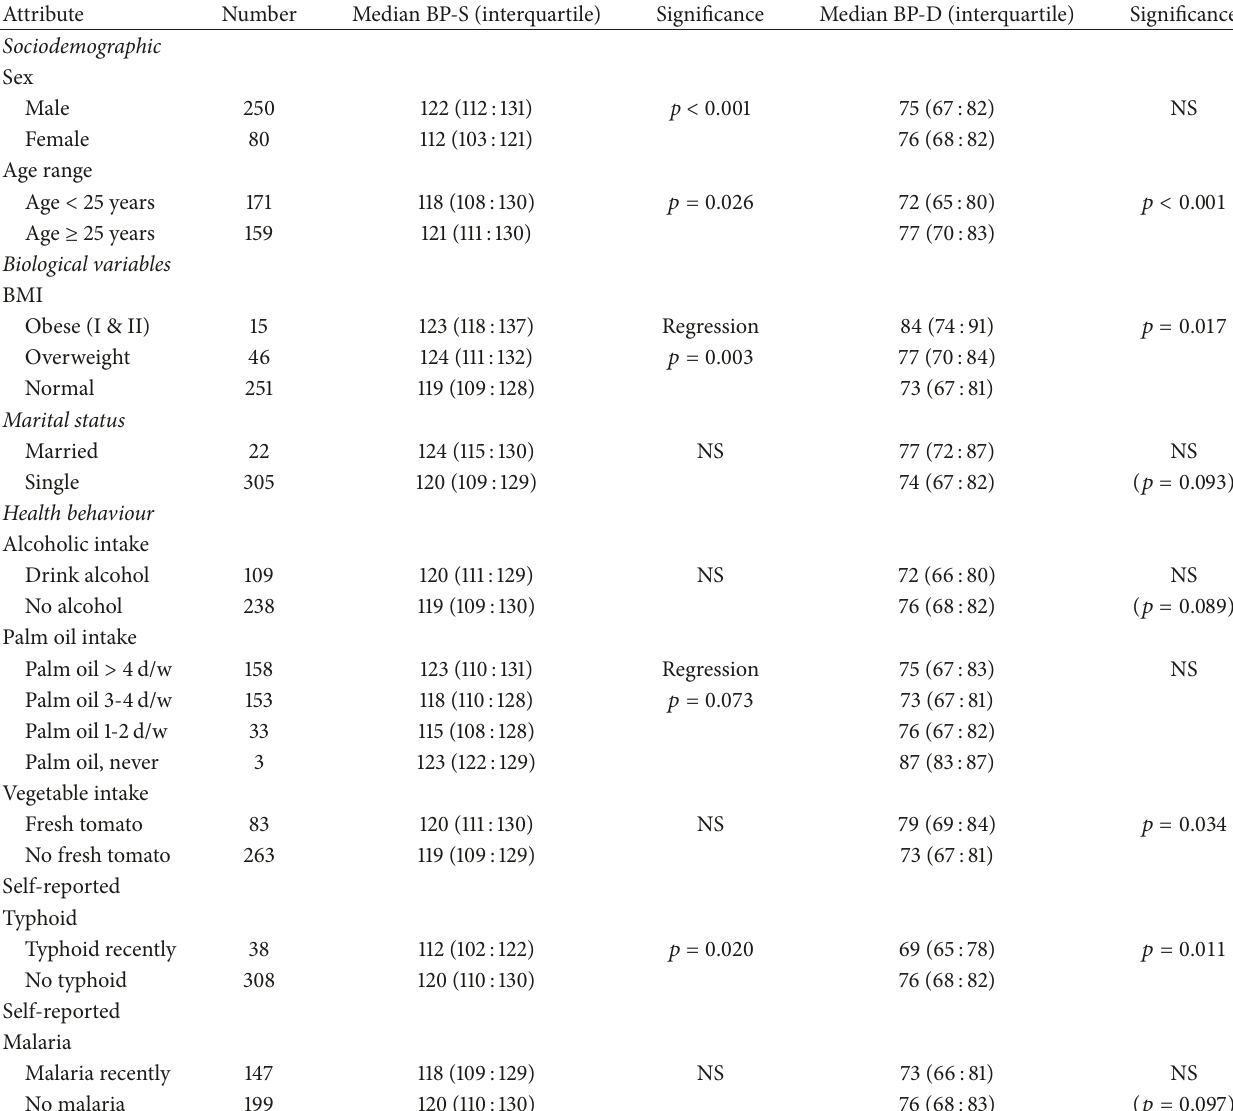
Table 2: Potential risk factors for the student population on Njala campus (probabilities from single factor ANOVA or linear regression). Attribute Number Median BP-S (interquartile) Significance Median BP-D